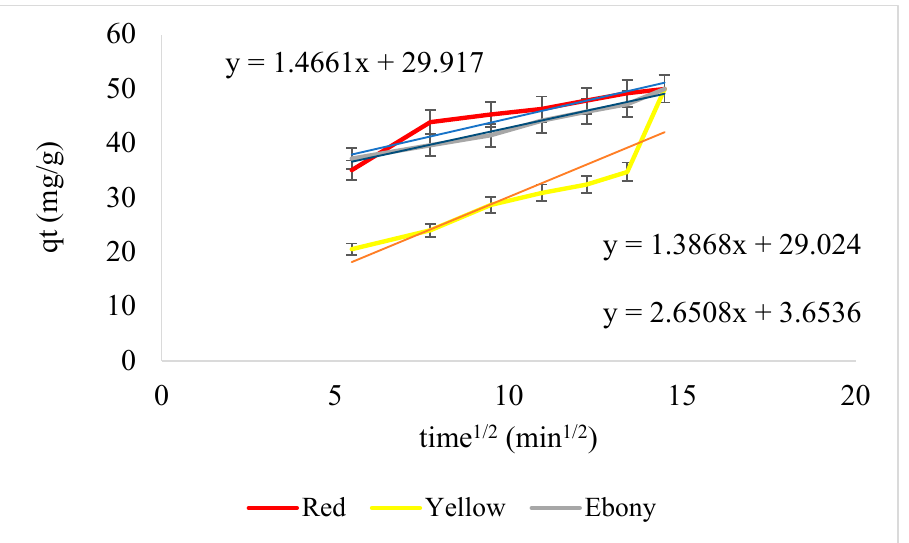
Figure 11. Intra-Particle Diffusion Plot for R, Y, and E hair dyes uptake onto COZ adsorbent . The nonlinear plot of Bt versus time in the Boyd model (Figure 12) confirms the intra- particle model results. Boyd’s model implies that external mass transfer mainly governs the rate of the adsorption process.